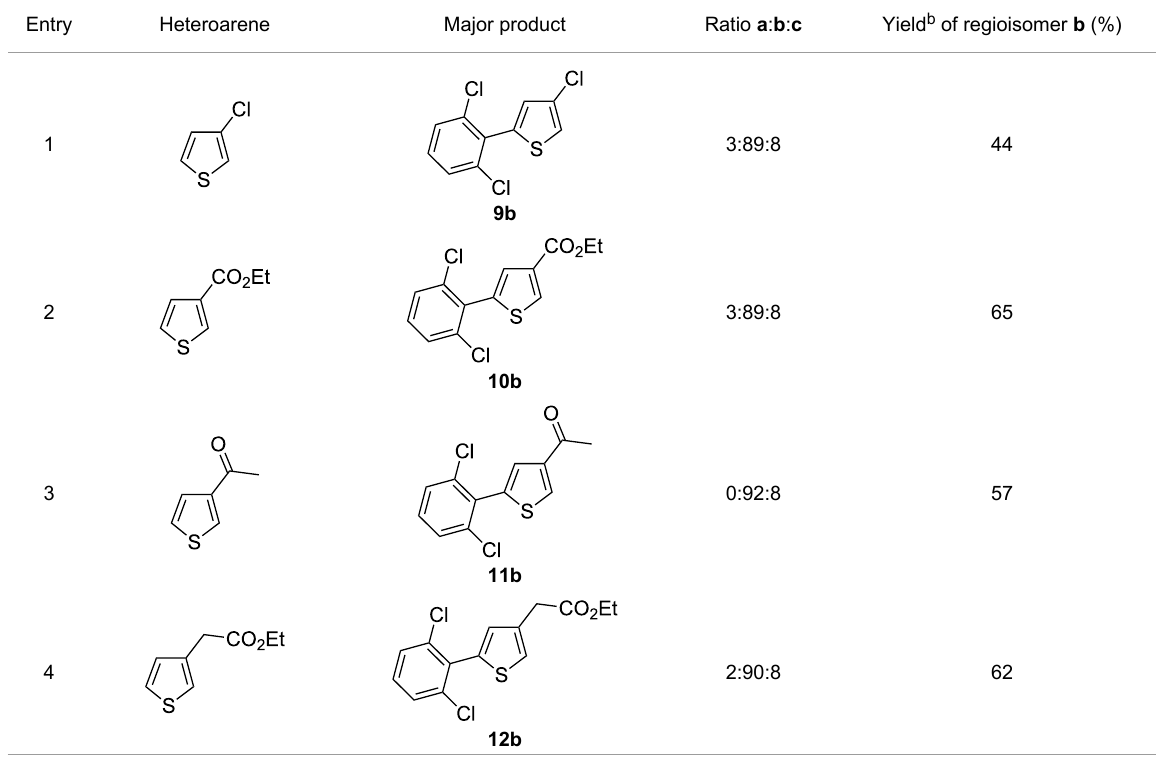
Table 1: Direct arylation of 3-substituted thiophenes with 2-bromo-1,3-dichlorobenzene (Scheme 3). a